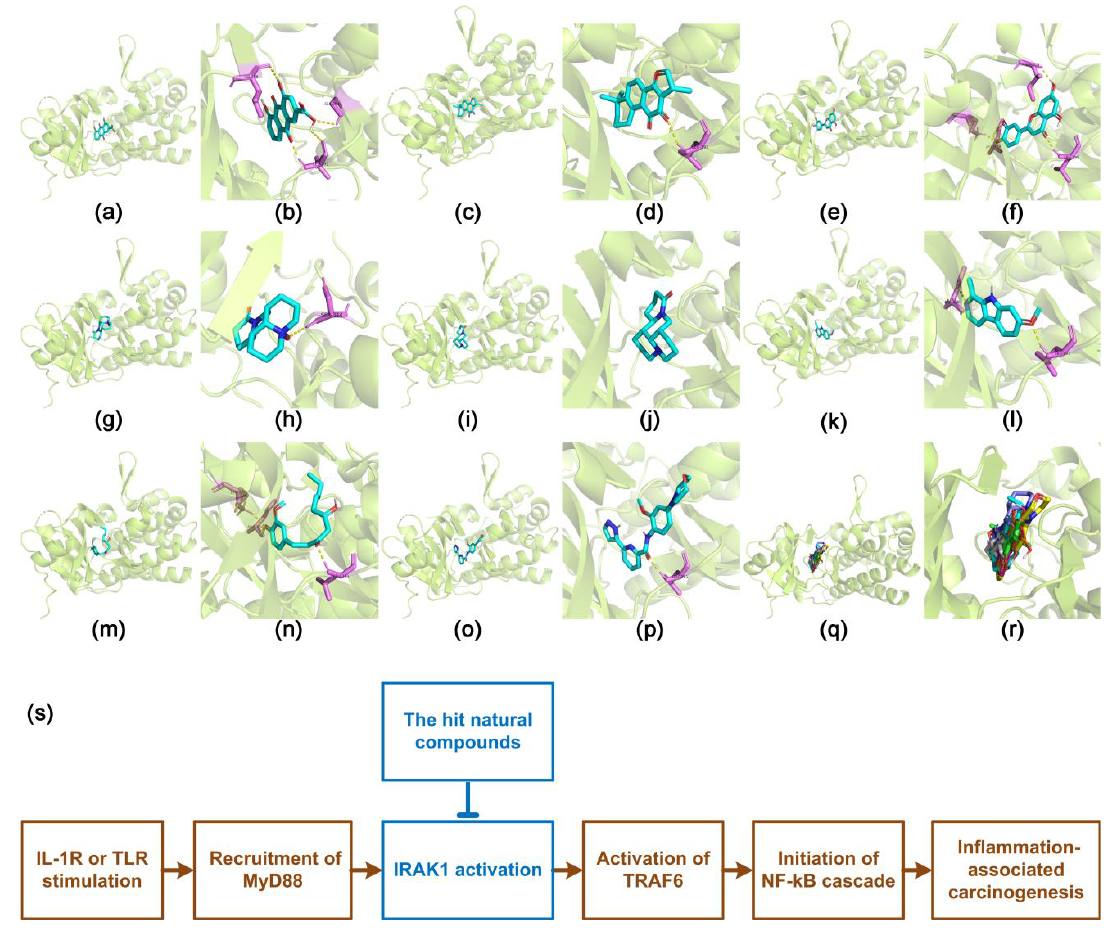
Figure 5. Docking poses of the selected natural compounds with IRAK1. ( a , b ) Rhein; ( c , d ) crypto- tanshinone; ( e , f ) luteolin; ( g , h ) oxymatrine; ( i , j ) matrine; ( k , l ) harmine; ( m , n ) gingerol; ( o , p ) the re-docked original ligand inhibitor, JH-I-25; ( q , r ) superposed docking poses. Colors of the carbon skeleton: rhein in orange, cryptotanshinone in green, luteolin in violet, oxymatrine in blue, matrine in gray, harmine in magenta, gingerol in cyan, and JH-I-25 in yellow. Colors of other atoms: hydrogen (polar) in gray, nitrogen in blue, and oxygen in red; The panels ( a , c , e , g , i , k , m , o , q ) are in global view, whereas panels ( b , d , f , h , j , l , n , p , r ) are in active-site view; ( s ) proposed involvement of the hit com- pounds in the IRAK1/NF- κB signaling.